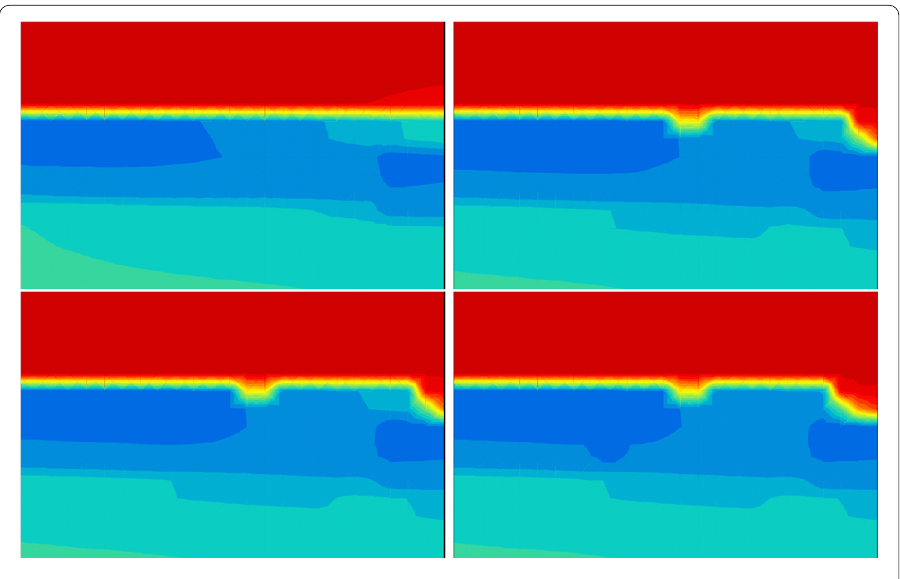
Fig. 14 A zoom on a grain boundary in the 32 grain microstructure, c.f. Figs. 5 and 10 (the subgrain boundary appears in the lower right quadrant of the microstructure in those figures). From left to right, top to bottom, the orientation field around the grain boundary is shown immediately after deformation, at 500, 1000 and 3600s, respectively. The grain is on the edge of the simulation box, and so the change in the profile to the very right in the figure is likely due to ordinary grain boundary migration. However, a little to the left there is a small bulge that appears which can not be explained by the geometry